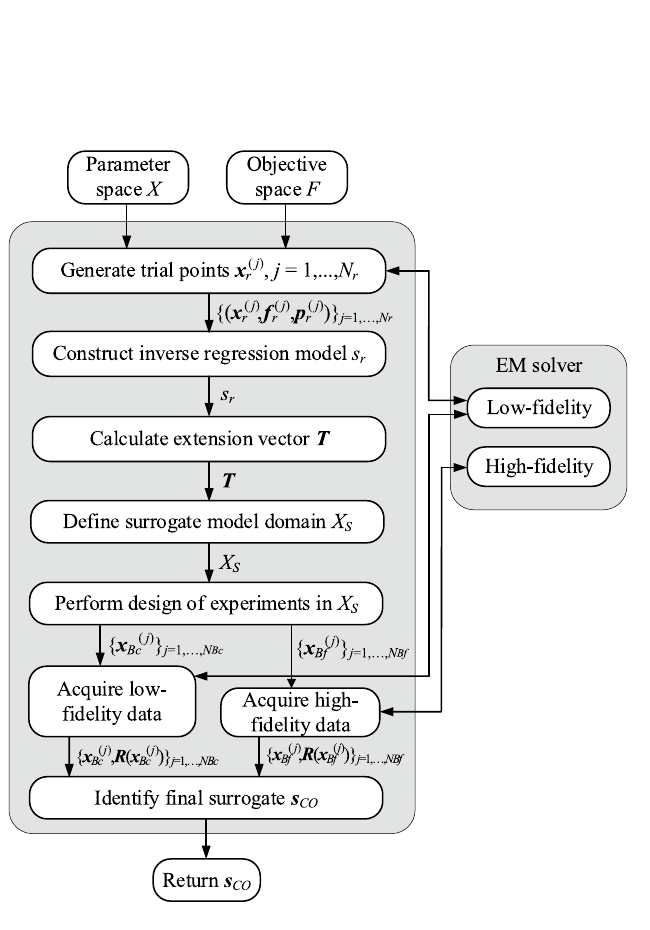
Figure 7. Operational flow of the presented two-layer modeling technique with domain confinement and variable-resolution EM